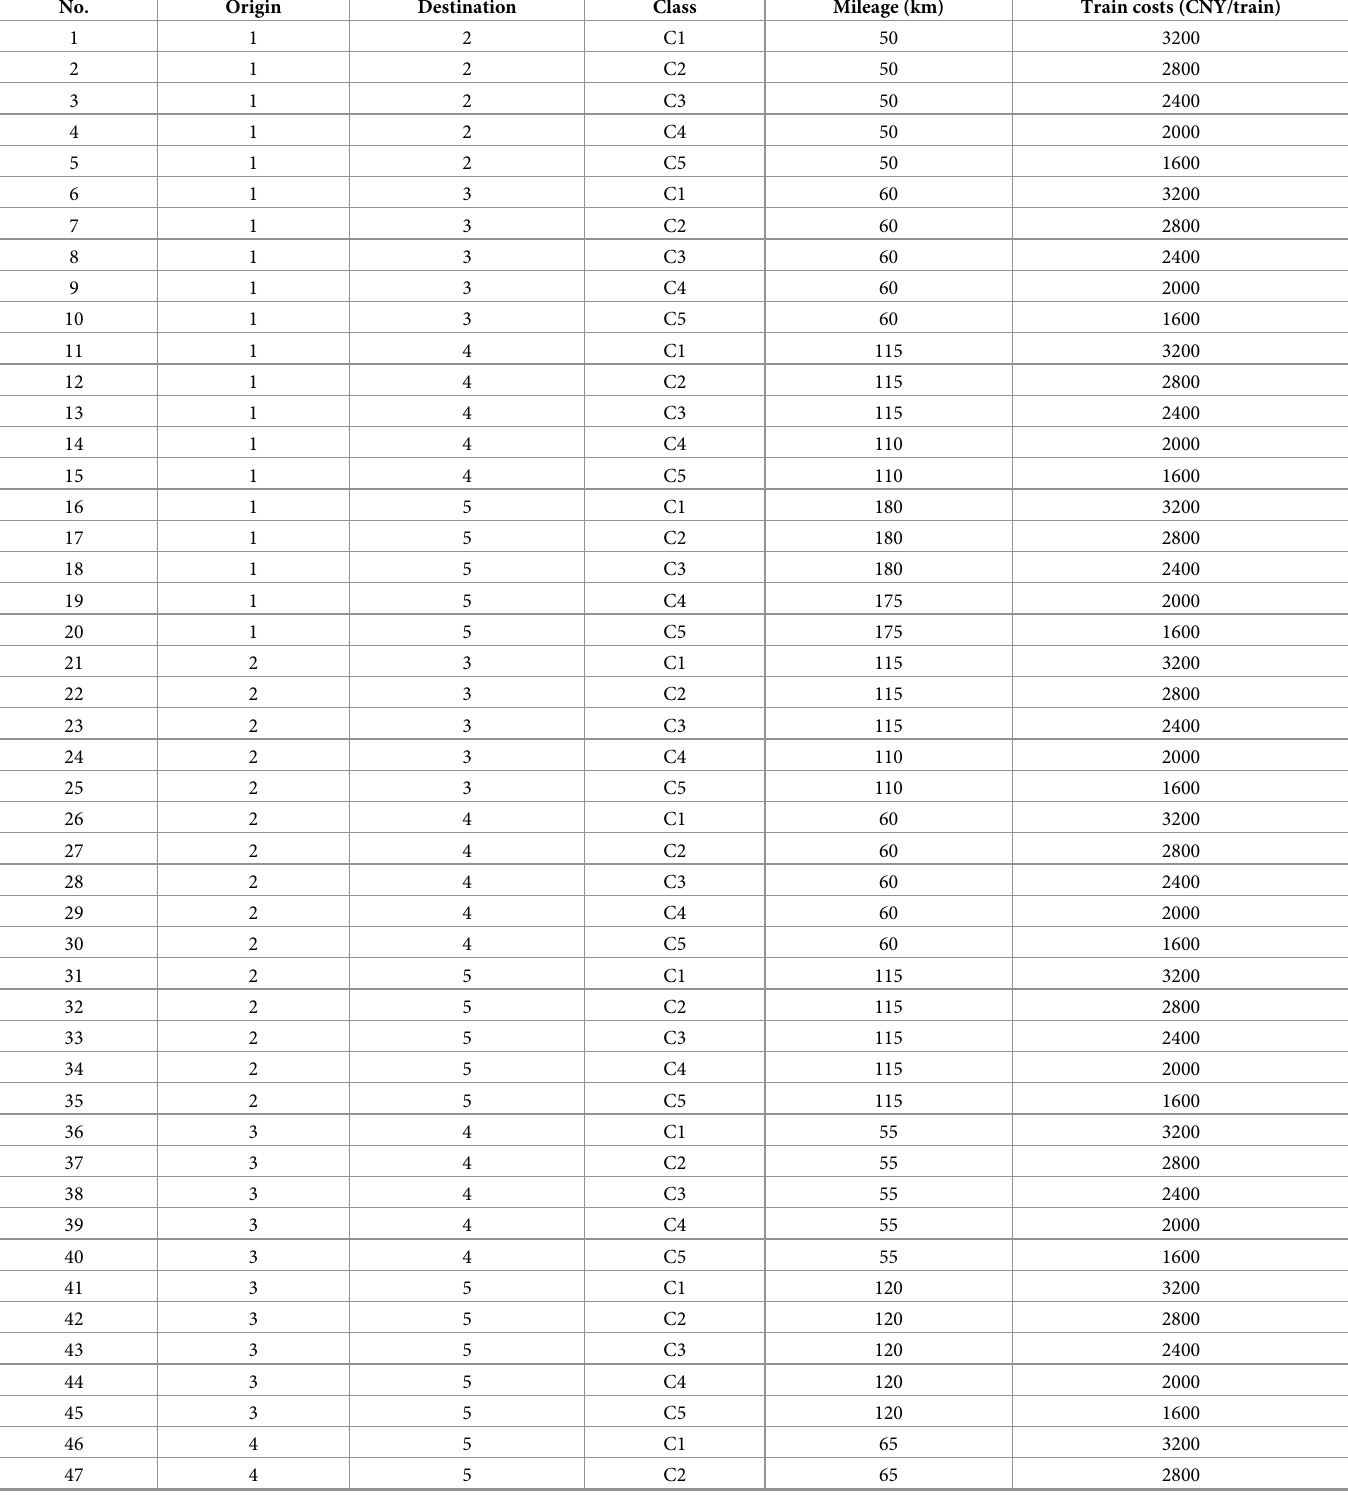
Table 8. Available train